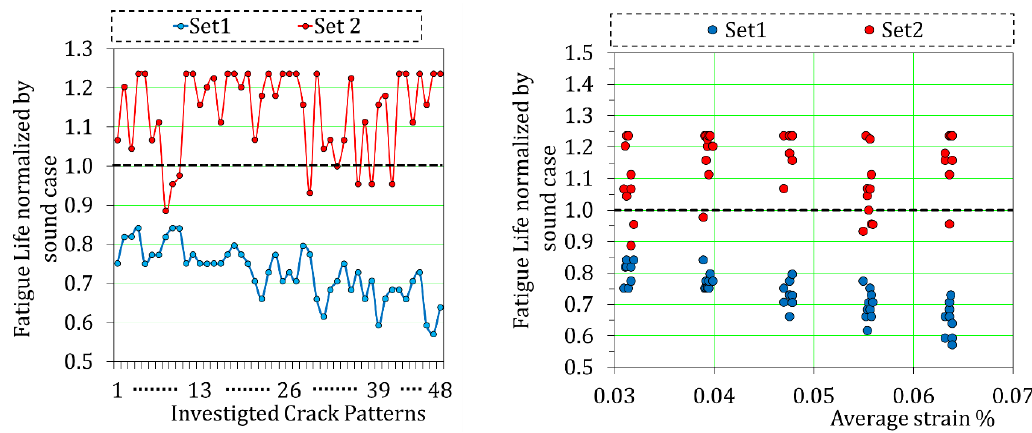
Figure 6. Comparison of sets 1 & 2 regarding the remaining fatigue life.